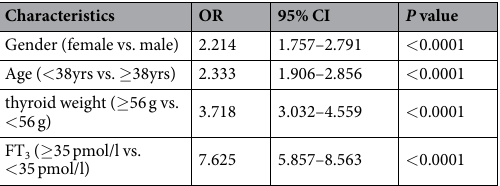
Characteristics OR 95% CI P value Gender (female vs. male) 2.214